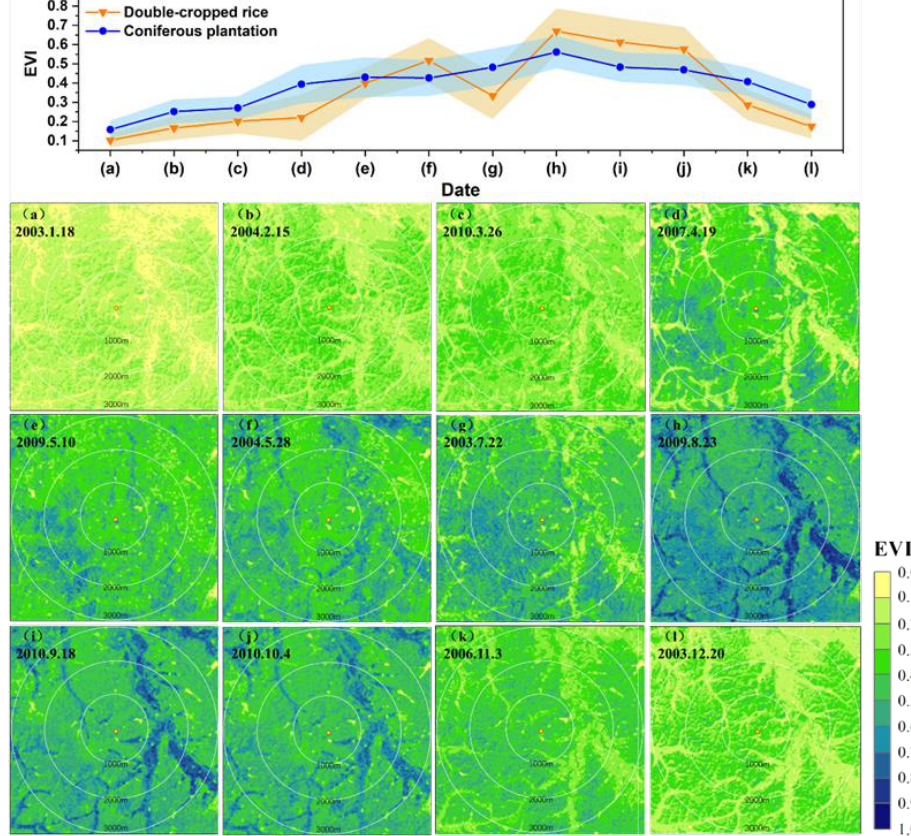
Figure 4. Seasonal variation in EVIs from the double-cropped rice and the coniferous plantation in different months (the upper figure) and their spatial variation in EVIs over the flux site (the lower figures ( a – l )). The symbols ( a – l ) in the upper figure are consistent with them in the lower figures. For example, the symbol ( a ) means 18 January 2003.